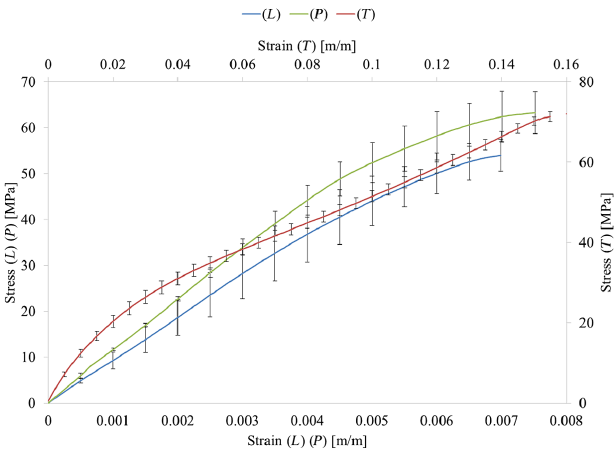
FIG. 20. Plot of compressive stress against strain for CFC. Longitudinal data and relevant axes marked with ( L ). Transverse data and relevant axes marked with ( T ). Perpendicular data and relevant axes marked ( P ).